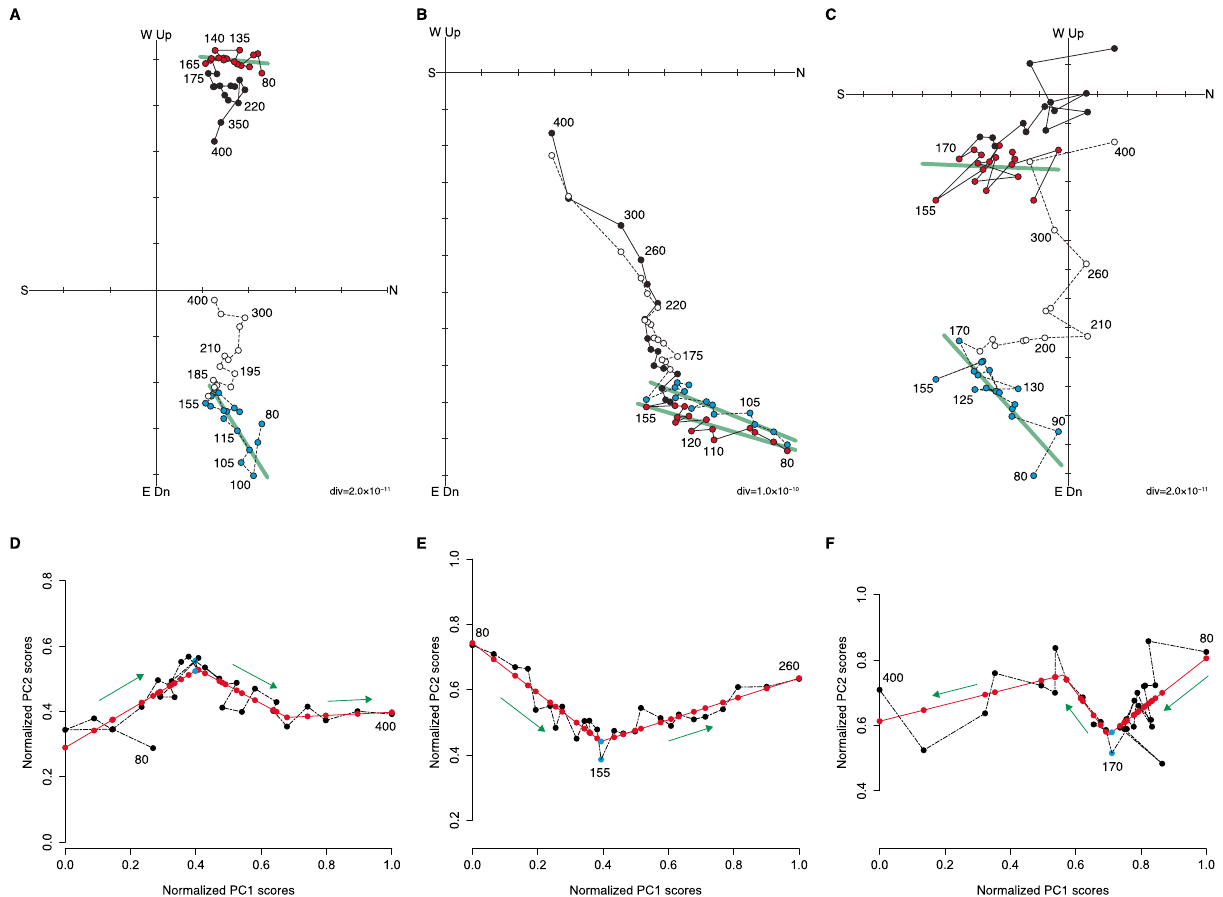
Figure 3. Vector plots and directional analysis of tsunami boulders. ( A – C ) Vector plots of tsunami boulders: ( A ) TB2-2, ( B ) TB4-2, and ( C ) TB6-1. Black and red circles represent the horizontal direction and white and blue circles indicate the vertical direction. Red and blue circles represent the VRM component and green lines represent the VRM direction obtained from PCA analysis. ( D – F ) Plots of PC1 scores and PC2 scores (black dots with lines) and segmented linear regression results (red dots with lines) for the datasets with scores normalized by the maximum and minimum scores of PC1 and PC2: ( D ) TB2-2, ( E ) TB4-2, and ( F ) TB6-1. The blue dots represent the inflection